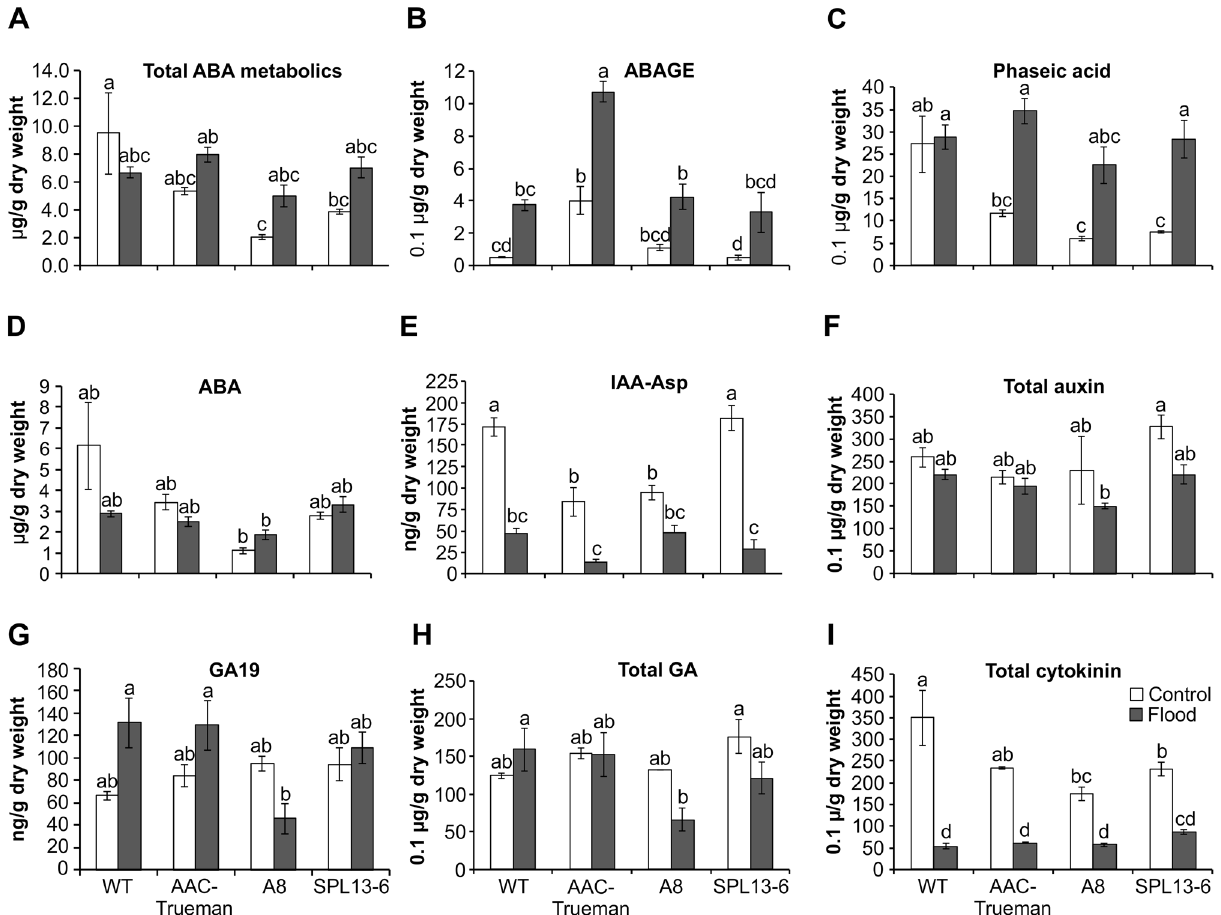
Figure 2. UPLC/ESI–MS/MS-based hormone profiling in flood stressed and control alfalfa genotypes. ( A ) The abundance of total abscisic acid, ABA, metabolites ( B ) abscisic acid glucose ester, ABAGE, ( C ) phaseic acid, PA, ( D ) ABA, ( E ) indole acetic acid-aspartic acid, IAA-Asp, ( F ) total auxin, ( G ) gibberellic acid GA19, ( H ) total gibberellic acid GA, and ( I ) total cytokinin in ng per gram leaf dry weight. Total ABA metabolites in ‘ A ’ comprises ABA, Dihydrophaseic acid (DPA), ABAGE (Abscisic acid glucose ester), Phaseic acid (PA), 7 ′ -Hydroxy-abscisic acid (7 ′ OH-ABA), neo-Phaseic acid (neo-PA), and trans-Abscisic acid (t-ABA). Total auxin in ‘ F ’ comprises Indole-3-acetic acid (IAA) and N-(Indole-3-yl-acetyl)-aspartic acid (IAA-Asp). Total gibberellic acid in ‘H’ comprises gibberellin 8, 9, 19, 20, 24, 29, 34, 44, 51, and 53. Total cytokinin in ‘ I ’ comprises (trans) Zeatin-O-glucoside (t-ZOG), (cis) Zeatin-O-glucoside (c-ZOG), (cis) Zeatin riboside (c-ZR), Dihydrozeatin riboside (dhZR), Isopentenyladenosine (iPR), Values are sample means ± SE, n = 3 individual plants as biological replicates. A significant difference from ANOVA was followed by Post hoc Tukey multiple comparisons test and indicated with different GDSL-like lipase/acyl hydrolase contributes to plant response to abiotic and biotic stresses and to seed devel- opment by modulating lipid metabolism 46–49 . A comparison of WT with the other genotypes under FS identi- fied two other major GDSL-related genes, including GDSL-like lipase/acyl hydrolase and Pmr5/Cas1p GDSL/ SGNH-like acyl-esterase (Fig. S4A). Of these genes, one of three in SPL13 RNAi-6, 29 of 33 in miR156 -A8, two of six in AC-Caribou and nine of 14 in AAC-Trueman were increased under flooding compared to FS WT (Fig. S4A). The second commonly increased transcript in all three genotypes ( miR156 -A8, SPL13 RNAi-6 and AAC-Trueman) codes for the reticuline oxidase-like protein which binds flavin adenine dinucleotide (FAD) that serves as hydrogen acceptor in a bi-covalent manner, and possesses an oxidoreductase activity in (S)- scoulerine biosynthesis 50 . The (S)-scoulerine alkaloid biosynthesis pathway is downstream of tyrosine required for the biosynthesis of important alkaloids such as berberine 51 . Transcripts of this gene were increased 1.7-fold in FS AAC-Trueman relative to its WD while other genotypes (WT, AC-Caribou, miR156 -A8, and SPL13R -6) showed a reduced 0.22 to 0.53-fold change compared to their respective WD (Fig. S4B). Despite this reduction, reticuline oxidase-like protein transcripts were increased 1.6 ( miR156 -A8) to sixfold higher (AAC-Trueman) relative to FS WT (Fig. S4B). To understand transcript plasticity of genotypes in response to flooding, we compared the transcript profiles of WD and FS plants of each genotype and compared their similarity. We identified 1071 upregulated and 1624 downregulated DEG shared by all genotypes (Fig. 3C). In addition, 89, 3764, 337, 471, and 437 upregulated